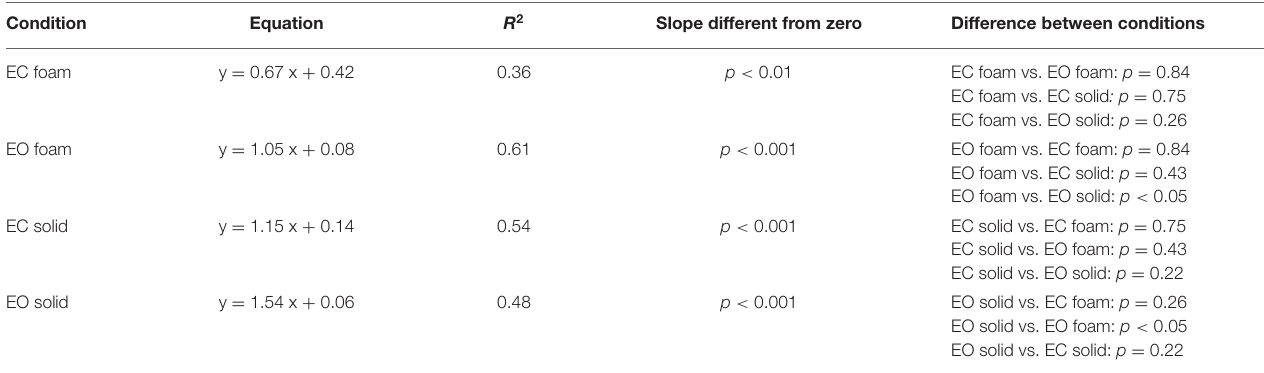
EO solid vs. EC solid: p =